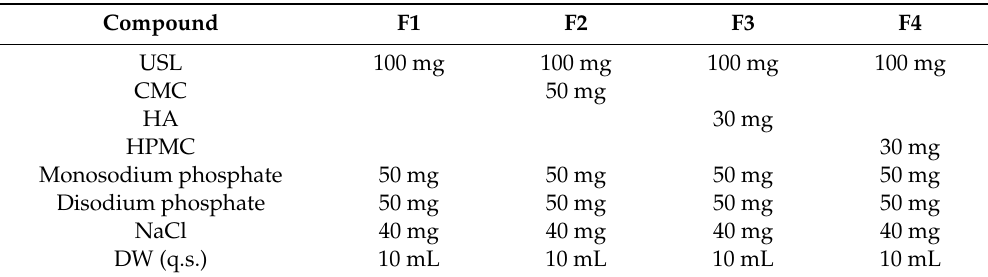
Table 1. Composition of each